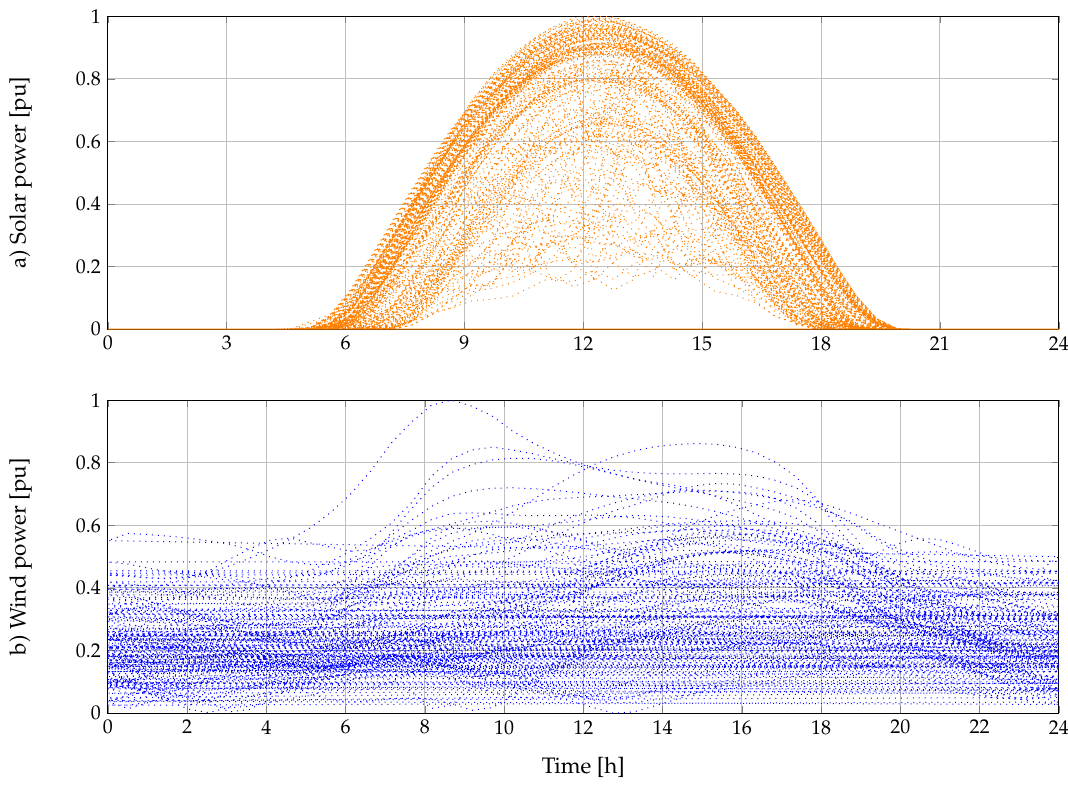
Figure 2. Historical data used for the ANN training process: ( a ) solar power; and ( b ) wind